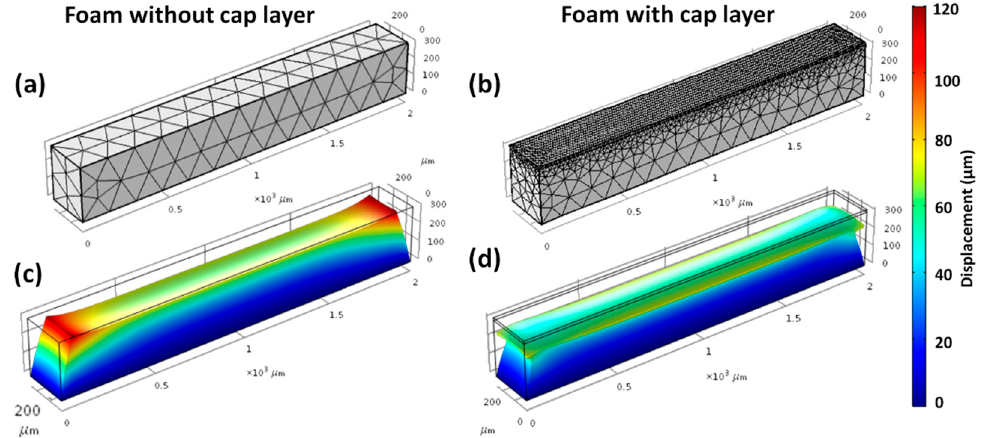
Figure 12. Mesh configuration used for the FEA simulations of foam rods fabricated in IP-Dip resin ( a ) without and ( b ) with a 15- µ m-thick fully dense cap layer and ( c , d ) the computed deformation due to shrinkage.